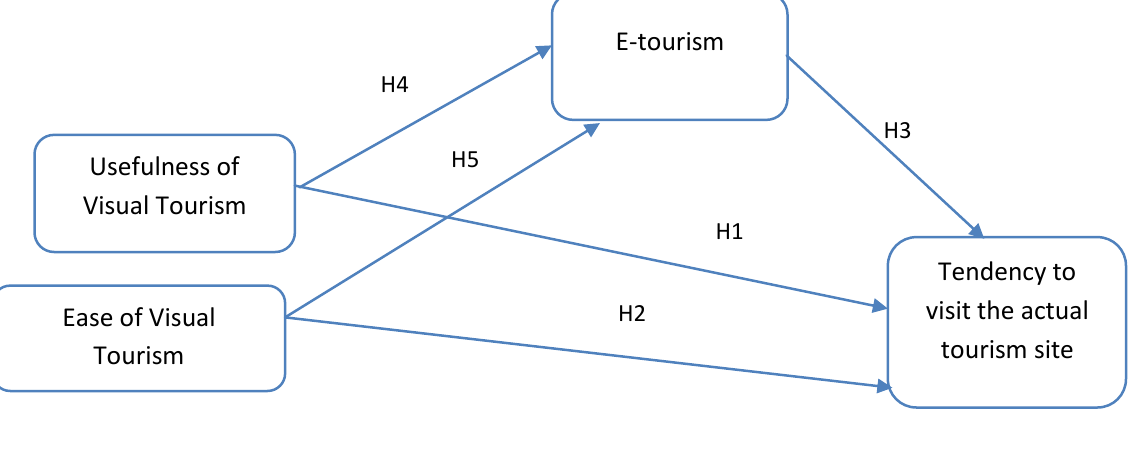
Figure 1: Conceptual Model (Source: Authors‘